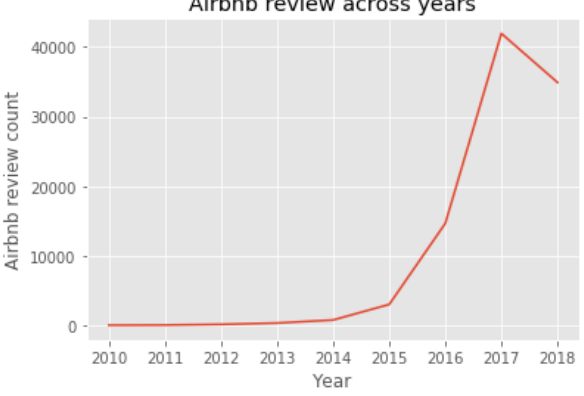
Figure 2. Airbnb reviews during years in the study area.